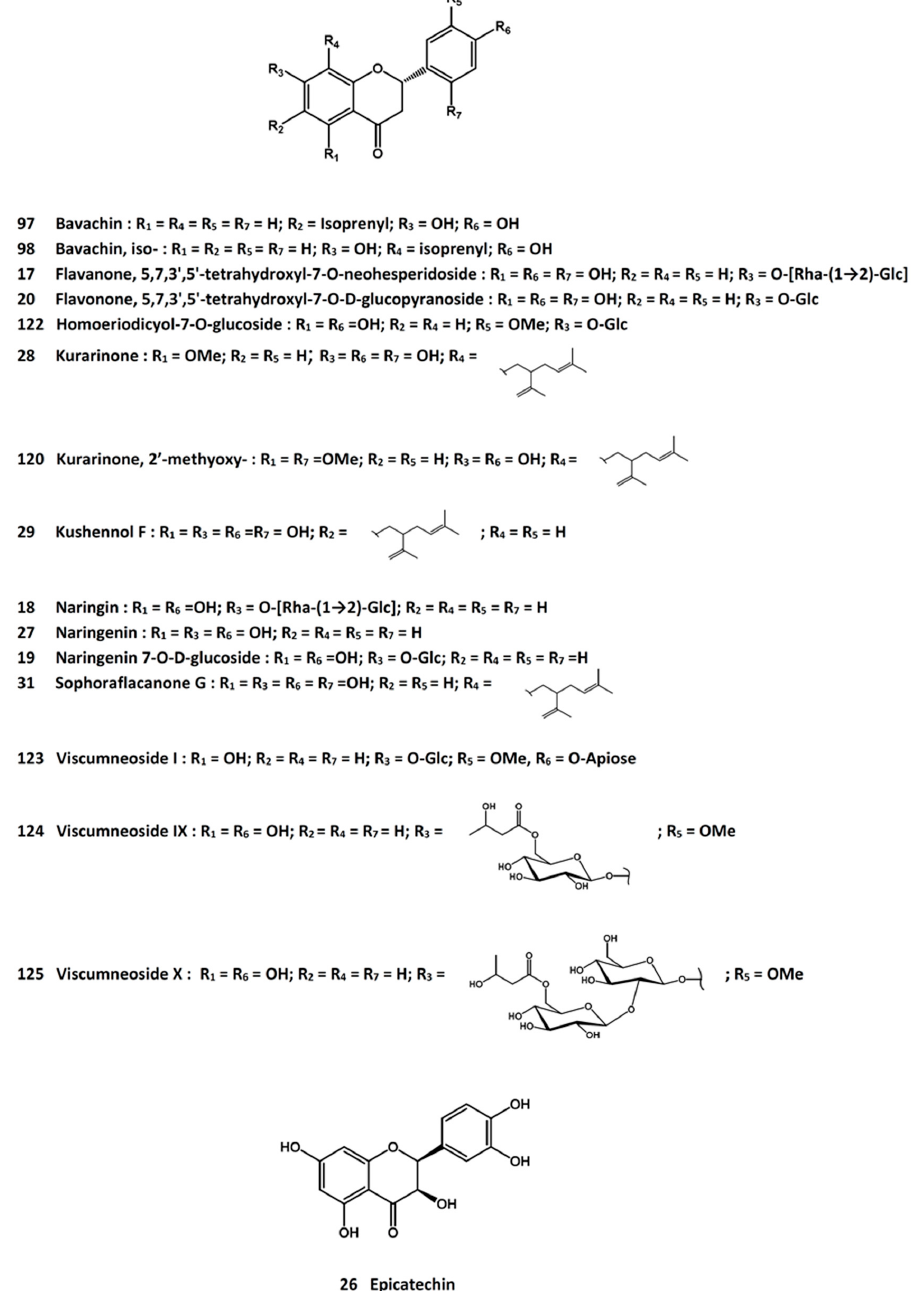
Figure 5. Flavanones Reported to Possess Osteoprotective Property.